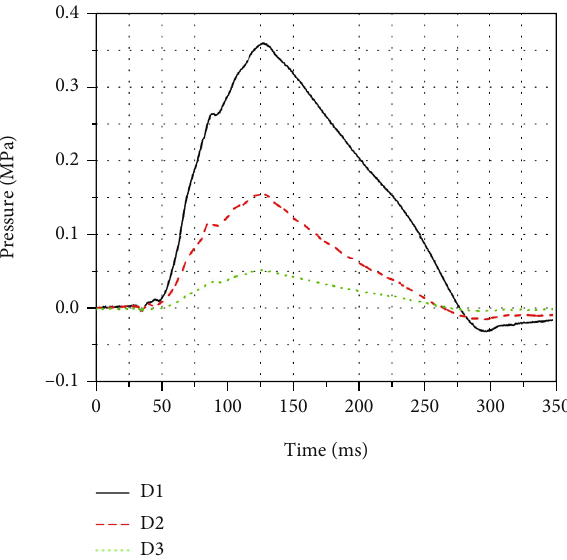
Figure 13: First shock pressure